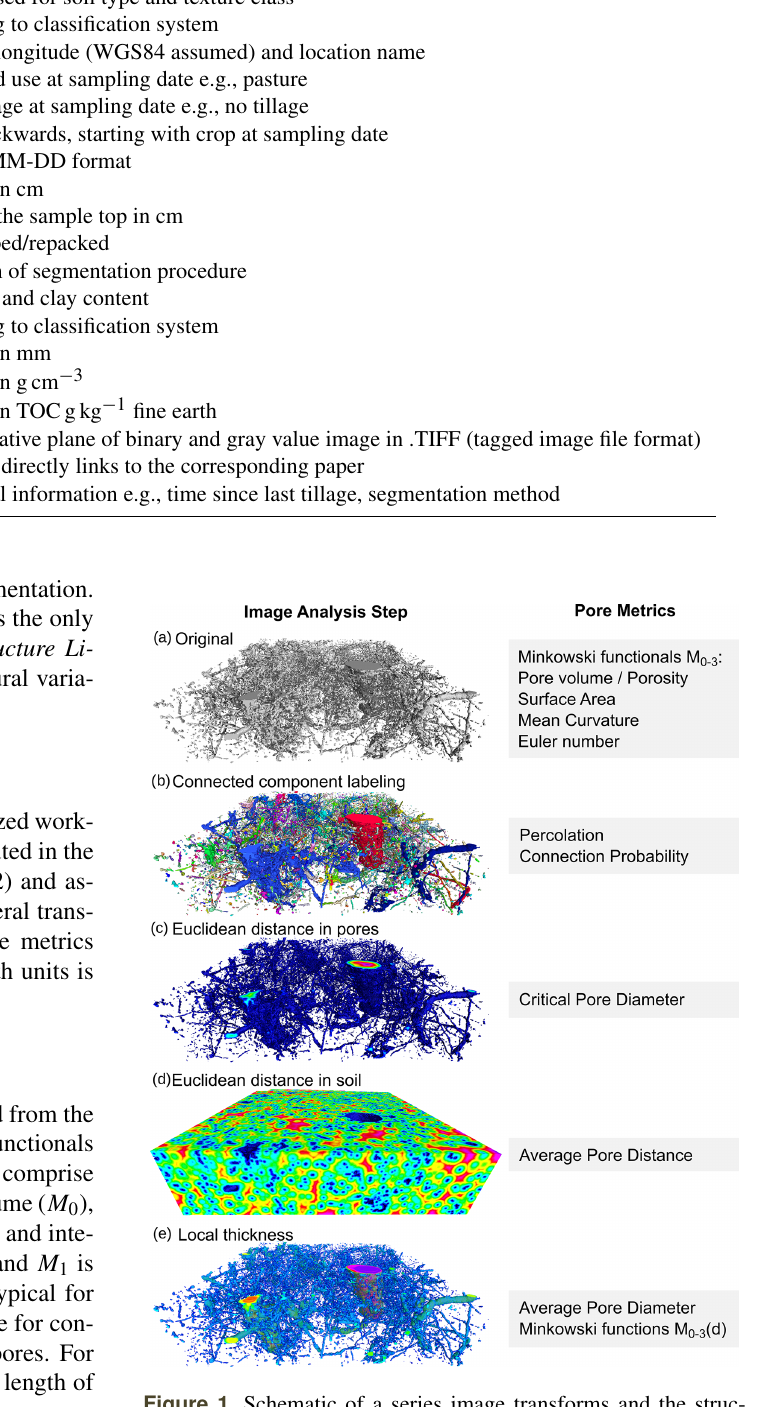
Figure 1. Schematic of a series image transforms and the struc- ture metrics derived from it. The pore structure is taken from a 30 × 30 × 10mm volume of a fine-textured topsoil managed as no-